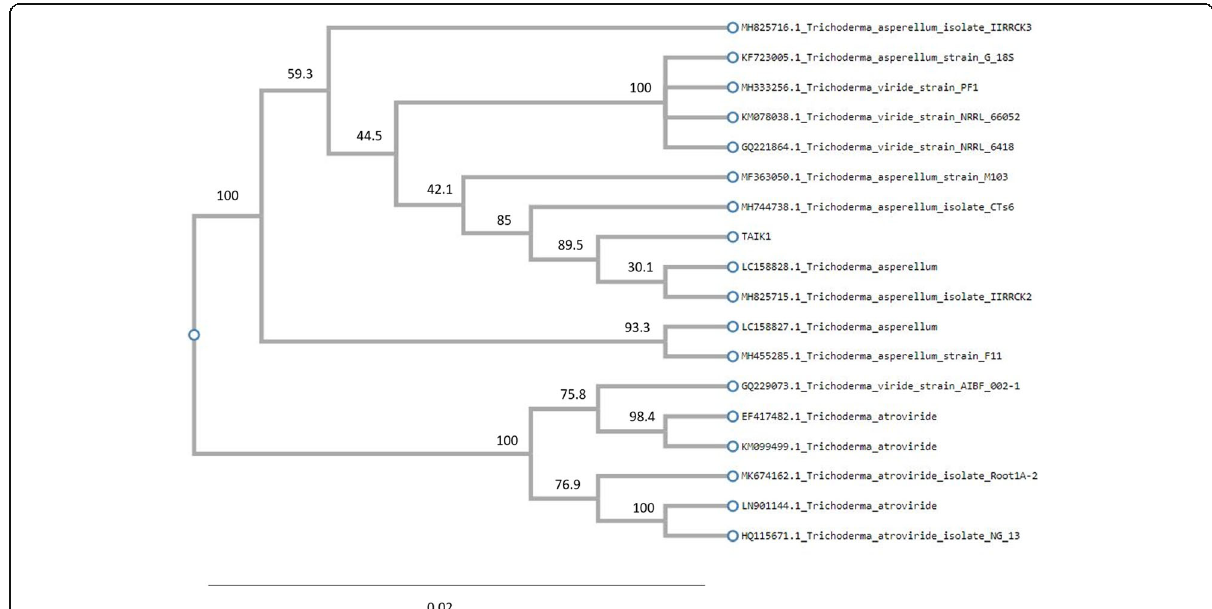
Fig. 2 Phylogenetic tree of TAIK1 with other Trichoderma isolates based on the sequence of internal transcribed spacer (ITS) (ITS1, 5.8 S and ITS2)